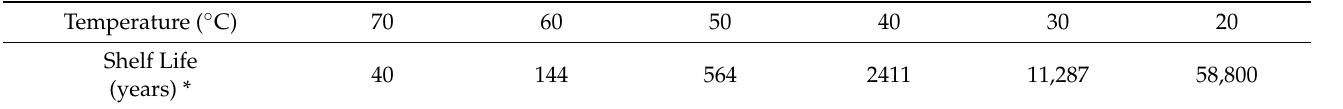
Table 6. Kinetic predictions of the shelf life of PA at different